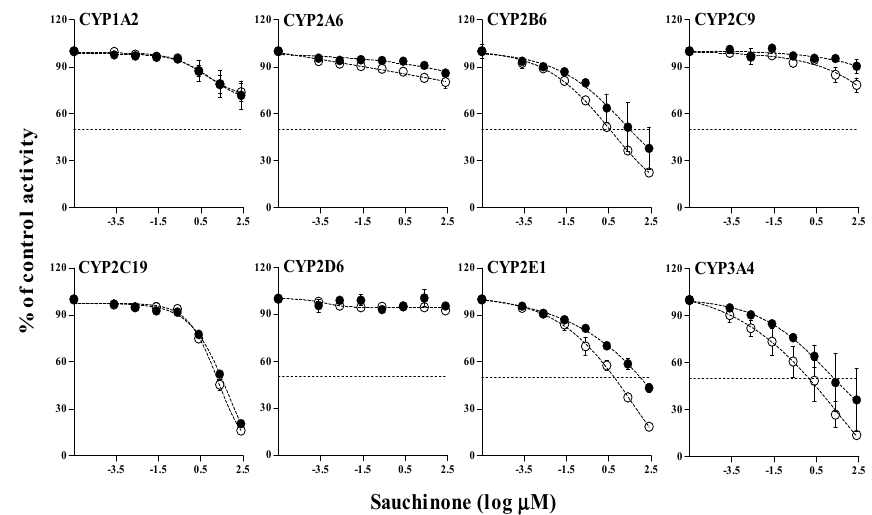
’ represent 0 (cid:35)